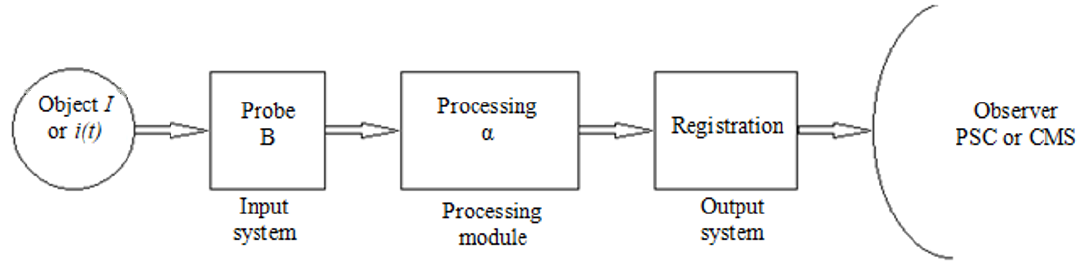
Figure 6. Measuring circuit (processing train) with chain structure for the polarimetric current sensor with the fiber optic measuring coil (Object: power line phase conductor; Probe: optical fiber; Processing: polarimeter; Registration: PC; Observer: the person taking the measurement; PSC: power safety controls; and CMS: control and monitoring systems).